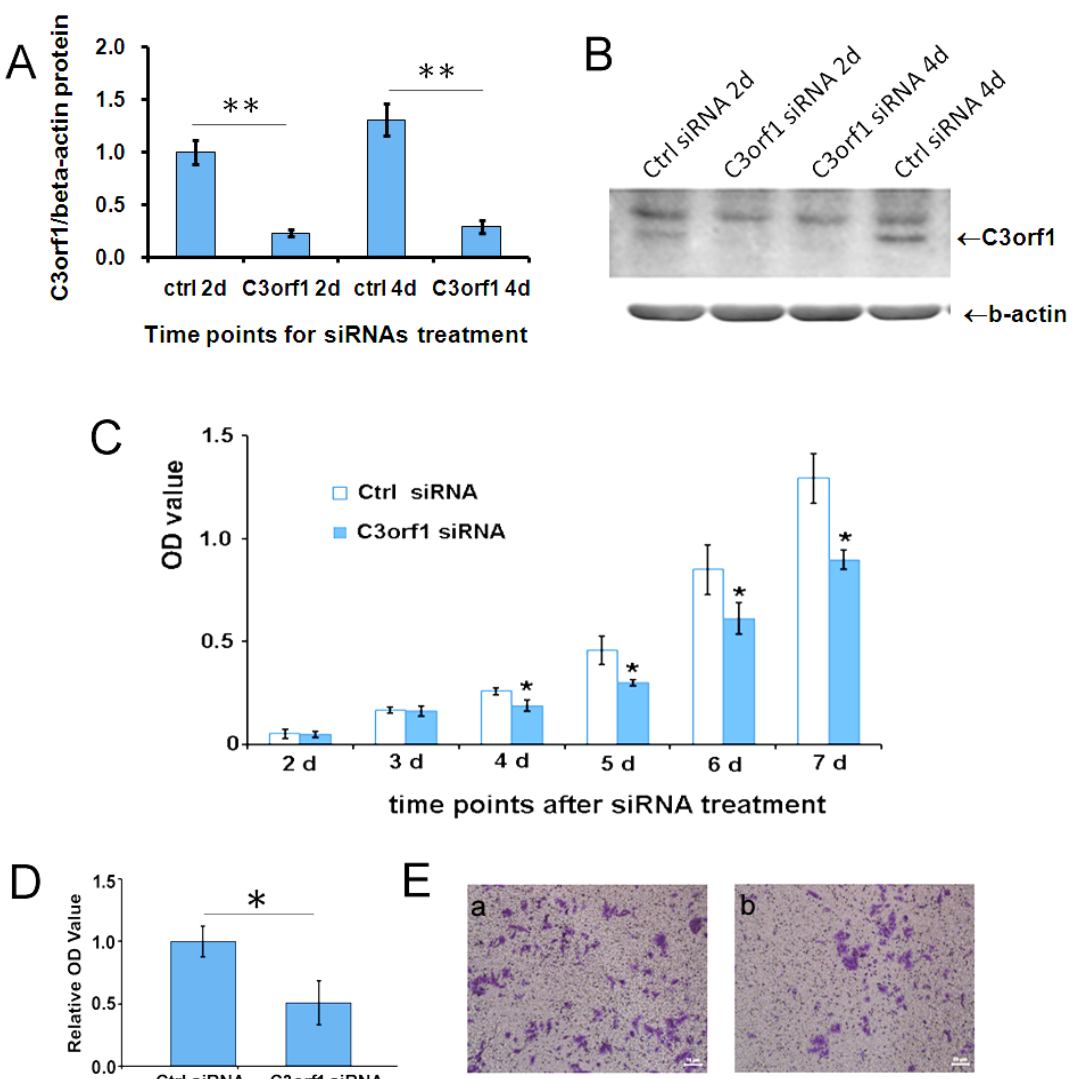
Figure 2. Depletion of C3orf1 in 95D cells inhibits cell proliferation and migration. ( A ) The efficiency of different siRNAs was evaluated by Western blotting after siRNA transfection in 95D cells for 2 days (2d) and 4 days (4d). β-actin was used as an internal control. Data are represented as mean ± SD. The data were normalized as described above, and the average expression level of C3orf1 protein in 95D cells treated with ctrl siRNA for 2 days (2d) was set to 1; ** p < 0.01, n = 3; ( B ) Representative images of Western blotting results; ( C ) The cell proliferation curve indicating that depleting C3orf1 expression suppressed the proliferation of 95D cells significantly between day 4 (4d) and day 7 (7d). The data are represented as mean ± SD; * p < 0.05, n = 3; ( D ) Trans-well assays indicating that depleting C3orf1 expression decreased cell migration. Data are represented as mean ± SD. The data were normalized, and the average number of migrated 95D cells treated with ctrl siRNA was set to 1; * p < 0.05, n = 4; and ( E ) Representative images of stained trans-well assay membranes. Scale bar = 50